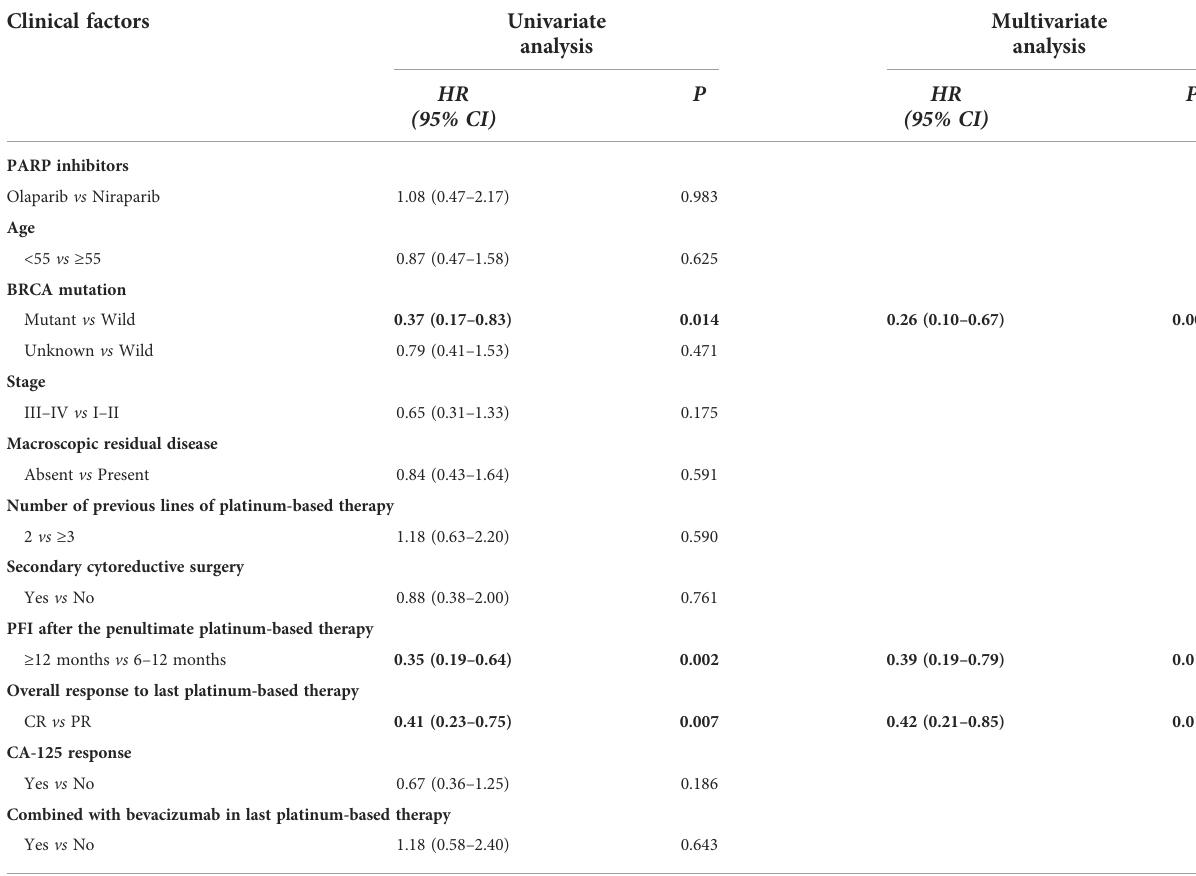
TABLE 3 Univariate and multivariate analysis of progression-free survival for the entire cohort. Clinical